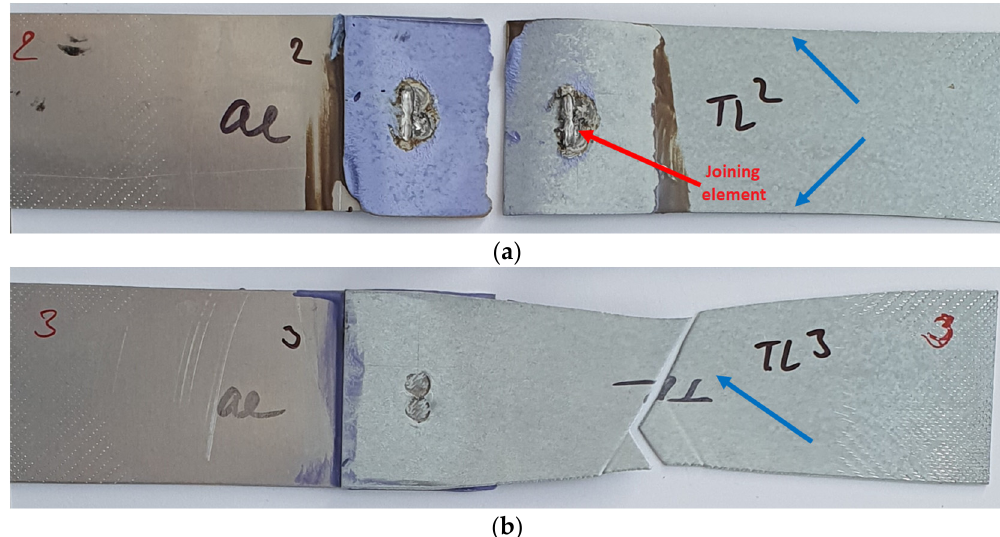
Figure 17. Fracture surfaces of Al-TL test joints made by resistance spot welding and AB after tensile shear test: ( a ) sample 2 and ( b ) sample 3, epoxy based adhesive.